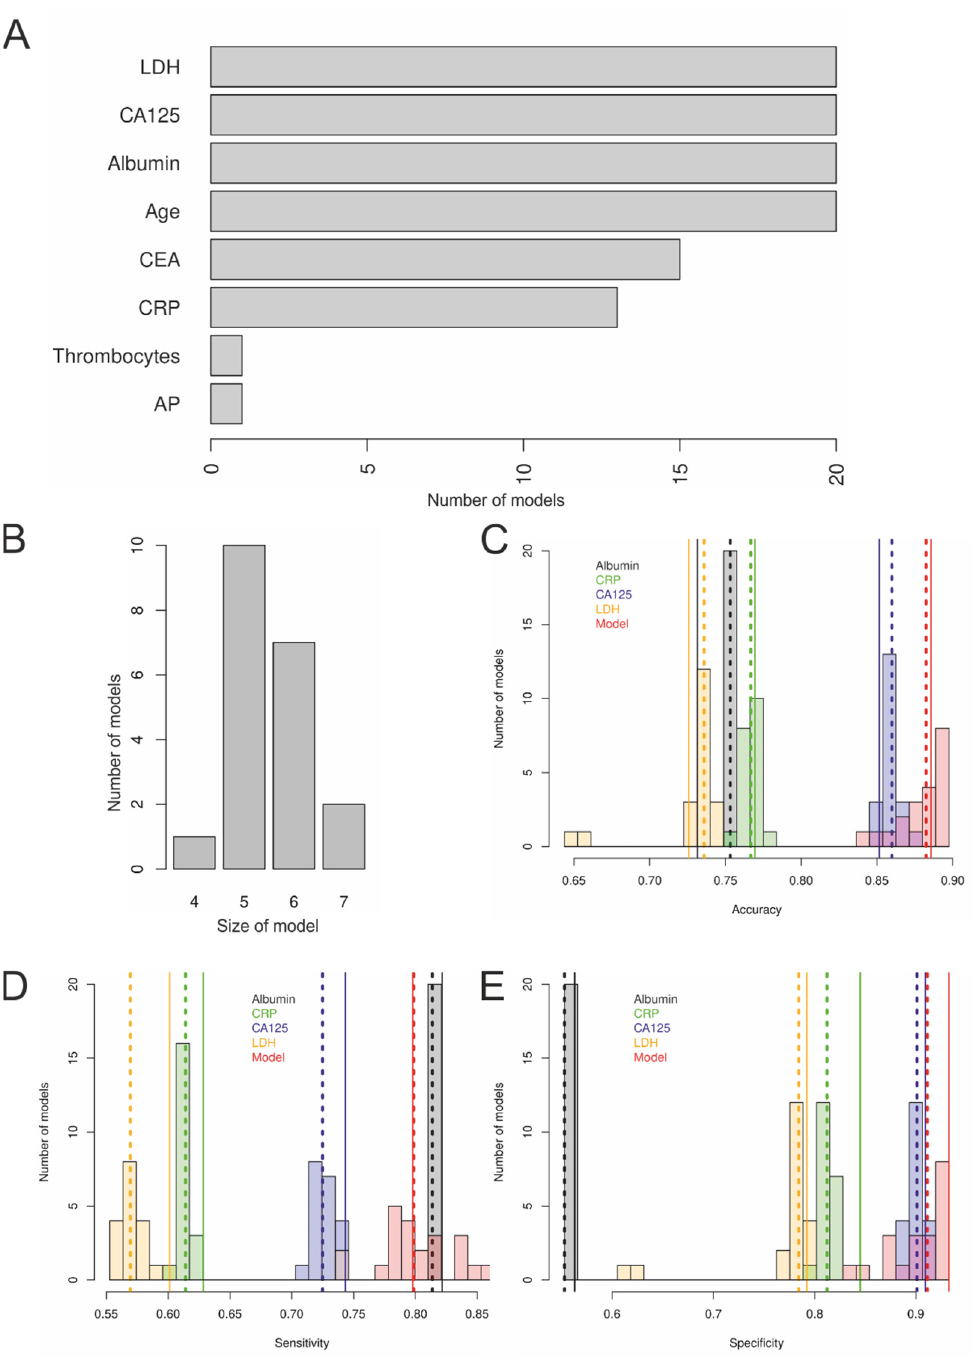
Figure 3. Building of the final models. ( A ) Four parameters were selected in all 20 (and the complete dataset) models, albumin, CA125, LDH, and age; ( B ) the models comprised four to seven parameters; ( C ) accuracy, ( D ) sensitivity, and ( E ) specificity of the most relevant single laboratory parameters compared to the 20 imputed models are shown, using a cut point optimized for the highest sum of sensitivity and specificity. The dotted lines represent the median values of the 20 imputed datasets. The solid line represents the value of the complete